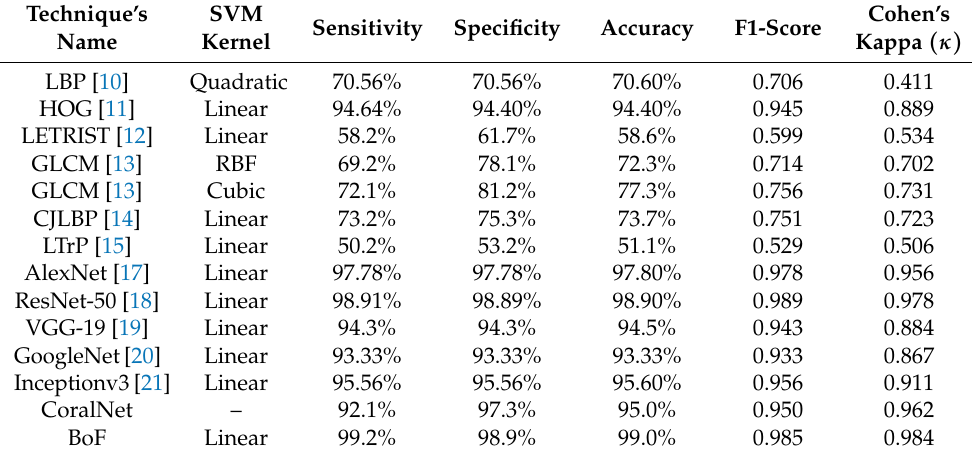
Table 3. Performance of hand-crafted descriptors and D-CNN models for second dataset (Bleached and Unbleached Corals).